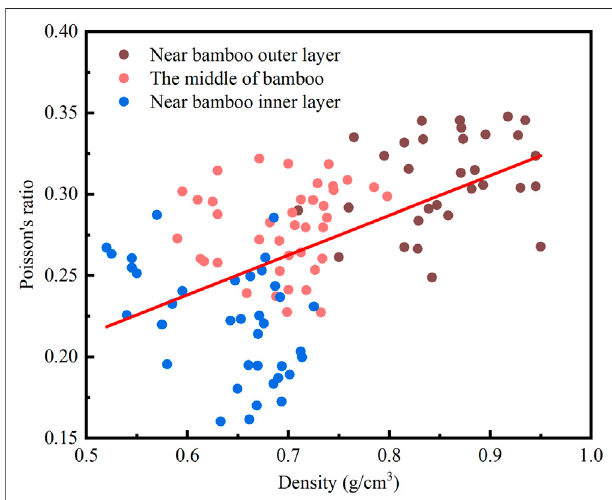
FIGURE 4 | Photograph of bamboo: from left to right the bamboo increases in height, from top to bottom in the radial direction from outside to inside.